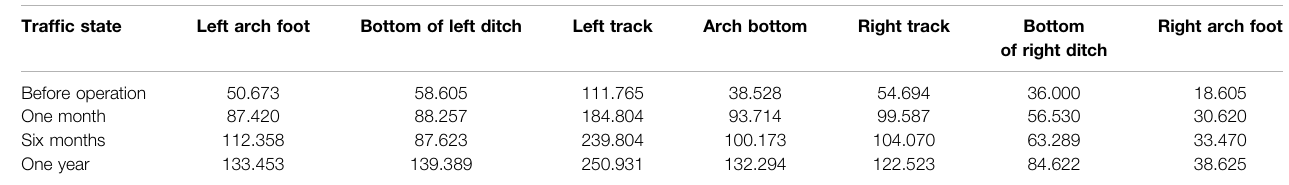
TABLE 2 | Water pressure of surrounding rock of Taihangshan tunnel basement